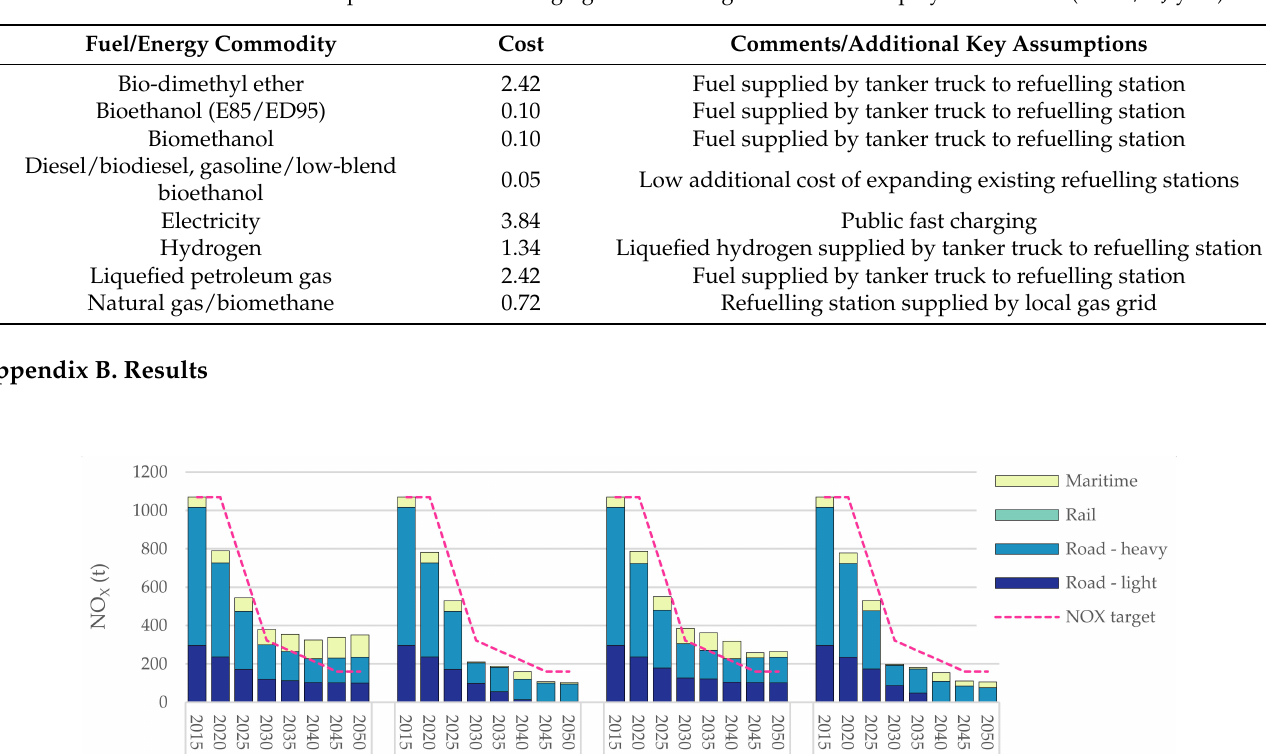
Table A6. Investment cost assumptions for new recharging and refuelling infrastructure deployed from 2016 ( € 2015/GJ · year).